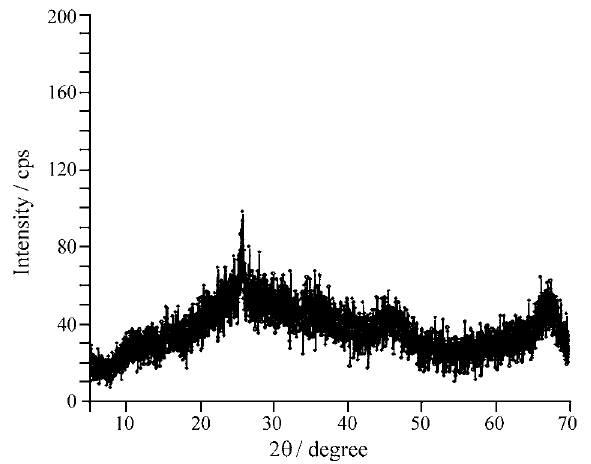
Figure 7. Difractograma de rayos-x de la fase sólida obtenida de una disolución 0.1 molar de Al 2 (SO 4 ) 3 un pH 10 después de dejarla envejecer dos días en el líquido